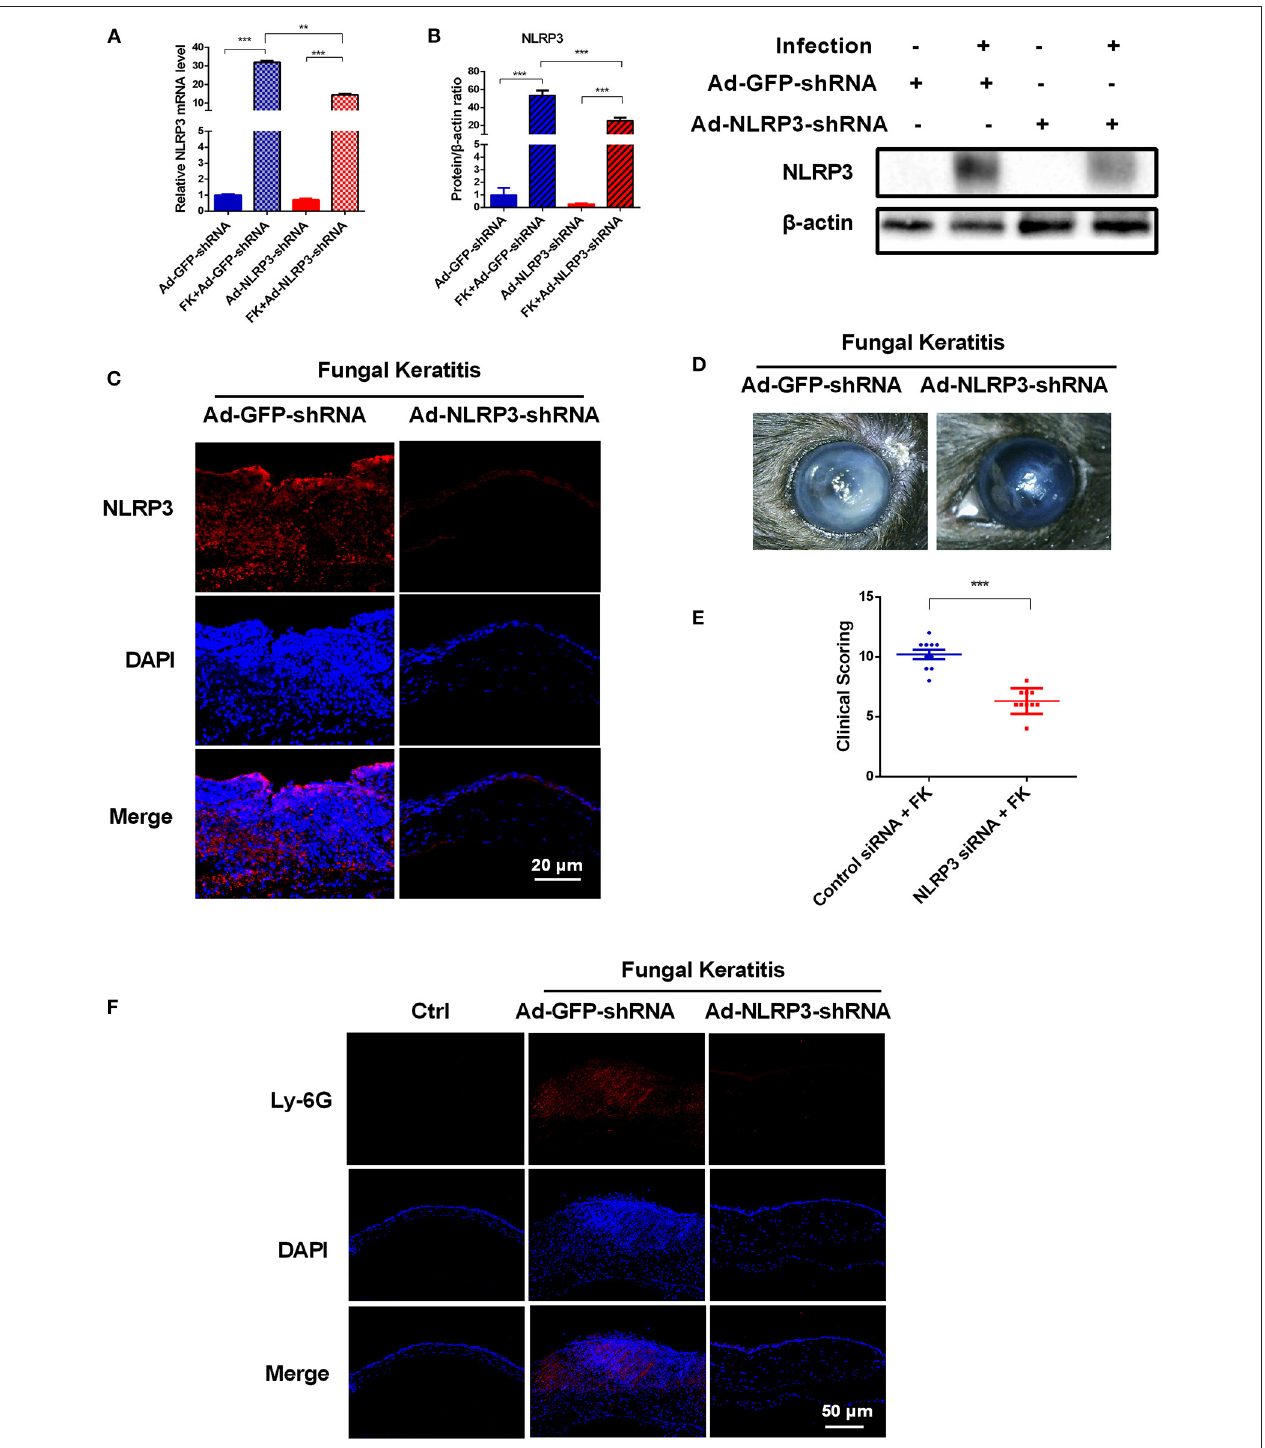
FIGURE 3 | NLRP3 knockdown decreases corneal inflammation and suppressed neutrophil infiltration in mouse C. albicans keratitis. The C57BL/6 mice were subconjunctivally injected with 6 µ L (4 × 10 8 PFU) of the Ad-GFP-shRNA or Ad-NLRP3-shRNA suspension 3 days before inoculation with 1 × 10 6 CFU C. albicans or with 5 µ L sterile PBS after the corneas were scratched. The mouse corneas or eyeballs were collected at 3 dpi and subjected for further detection. RT-qPCR analysis (A) , western blot (B) and immunofluorescence staining (C) were used to verify the gene knockdown efficiency of Ad-NLRP3-shRNA ( n = 3). Scale bar = 20 µ m; magnification 400 × . (D) Micrographs of Ad-GFP-shRNA and Ad-NLRP3-shRNA-pretreated mouse corneas were photographed at 3dpi. (E) Clinical score of the infected corneas pretreated with Ad-GFP-shRNA and Ad-NLRP3-shRNA ( n = 10). (F) Immunofluorescence staining was performed to assess the levels of neutrophils recruitment in mouse corneas after Ad-GFP-shRNA and Ad-NLRP3-shRNA pretreatment ( n = 3). Scale bar = 50 µ m; magnification 200 × . FK: fungal keratitis. All values are presented as mean ± SEM. ** p < 0.01; *** p < 0.001. Frontiers in Medicine |